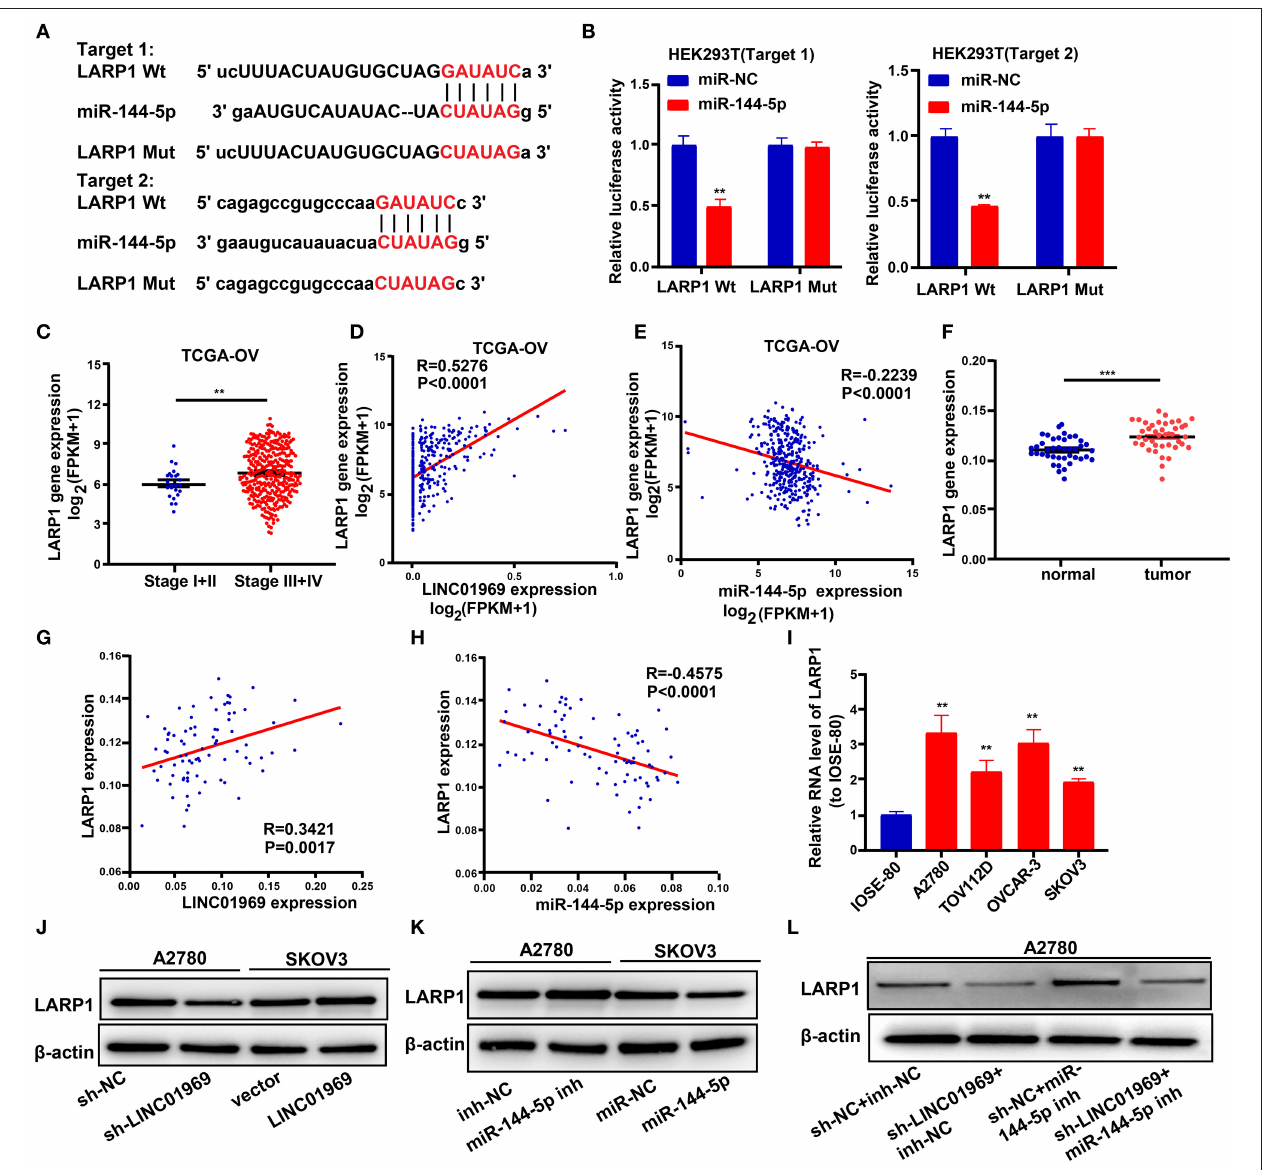
FIGURE 6 | LINC01969 regulates LARP1 by acting as a competing endogenous RNA (ceRNA) for miR-144-5p. (A) Two potential miR-144-5p binding sequences and mutation sequences of LARP1 messenger RNA (mRNA) were shown. (B) Dual luciferase reporter assays were used to confirm the direct target between LARP1 and miR-144-5p. (C) LARP1 expression in ovarian cancer (OC) stage I + II and stage III + IV from The Cancer Genome Atlas (TCGA) database. (D) The correlation analysis between LINC01969 expression and LARP1 expression in OC from TCGA database. (E) The correlation analysis between miR-144-5p expression and LARP1 expression in OC from TCGA database. (F) LARP1 gene expression in OC tissues and paired non-normal tissues from our dataset. (G) The correlation analysis between LINC01969 expression and LARP1 expression in OC tissues and paired non-normal tissues from our dataset. (H) The correlation analysis between miR-144-5p expression and LARP1 expression in OC tissues and paired non-normal tissues from our dataset. (I) LARP1 expression in OC cell lines and IOSE-80 cell line was analyzed by quantitative real-time PCR (qRT-PCR). (J–L) The level of LARP1 was detected by Western blot assay. Data were presented as mean ± SD; ** P < 0.01, *** P <